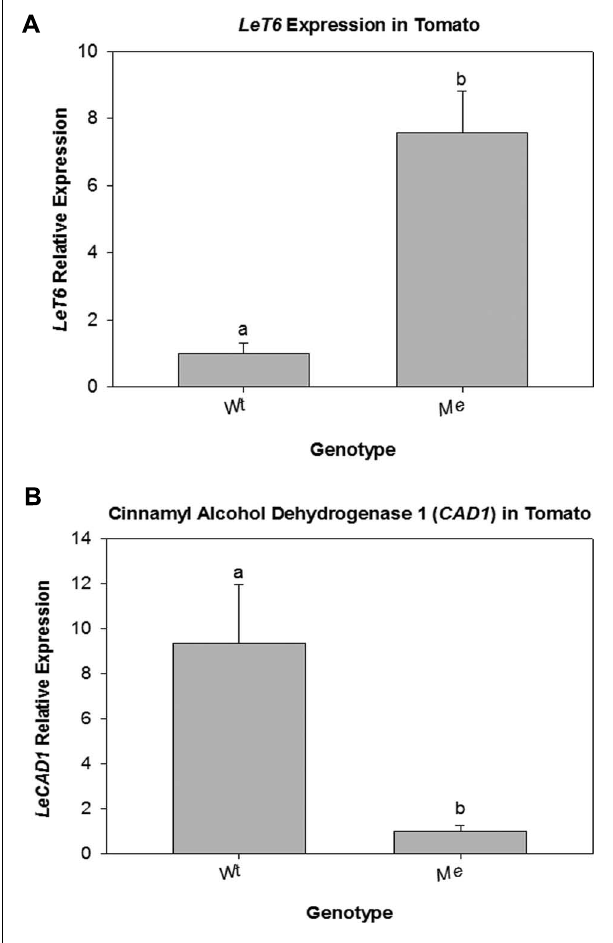
FIGURE 7 | (A) Relative expression of LeT6 in wild-type (Wt) tomato and in the tomato mutant Mouse ears ( Me ) plants. (B) Relative expression of LeCAD inWt and Me tomato plants. Error bars represent standard error [( ± SE; N = 3, P = 0.006 (A) and P = 0.033 (B)